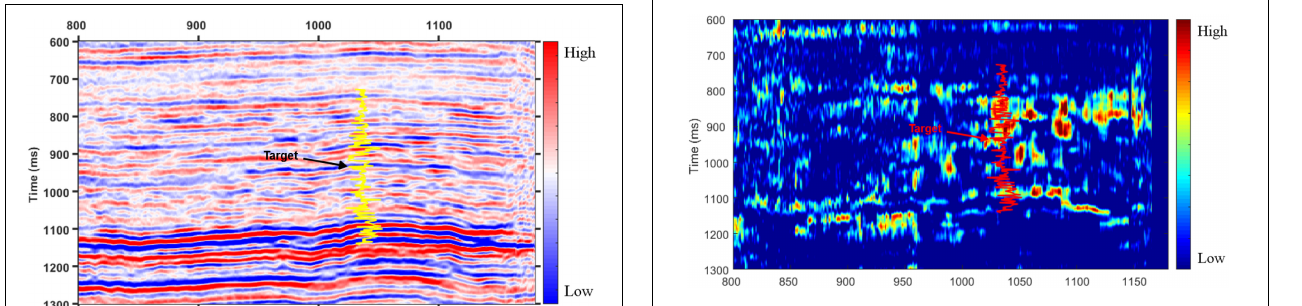
Frontiers in Earth Science |